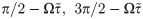
Delay-coupled heterogeneous oscillators with homogeneous bimodal-δ delays.Synchronization at frequency (A) Ω < μ and (B) Ω > μ. (a, b, e, f) Relative phases ϕi(t) of the synchronized and two unsynchronized oscillators (black) closest to the limits Ω ± Kr cos ΩΔτ. For comparison ±(Ω − μ)t are shown with dashed lines. Oscillators with (a, e) ωi < Ω and (b, f) ωi > Ω. (c, g) Geometric representation of ϕi of the synchronized oscillators (different shades of red diamonds for ωi < Ω and blue circles for ωi > Ω) at the end of the simulations. Limits π/2-Ωτ˜,3π/2-Ωτ˜ and -Ωτ˜ are dashed red. The arrows show the complex order parameter (black), angles Ωτ1,2 (blue), and Ωτ˜ and ΩΔτ (red). (d, h) PDF of the natural frequencies, the frequency Ω (black vertical line), and the limits of synchronization Ω ± rK cos ΩΔτ (red). Entrained (blue and red) and the first two un-synchronized (black) oscillators are consistent across the plots, and the rest are green. Parameters: Number of oscillators: N = 300, Lorentzian natural frequencies with μ = 1Hz and γ = 1 (A) τ = [0.02, 0.37]s, K = 6, (B) τ = [0.07, 0.63]s, K = 8.